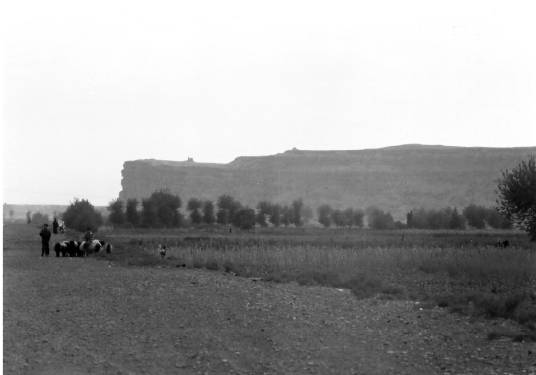
Figure 9. The visible ruins of tower tombs and towers of the fort at Tabus seen in silhouette at the edge of Jebel Bishri. Photo from NE: M. Lönnqvist